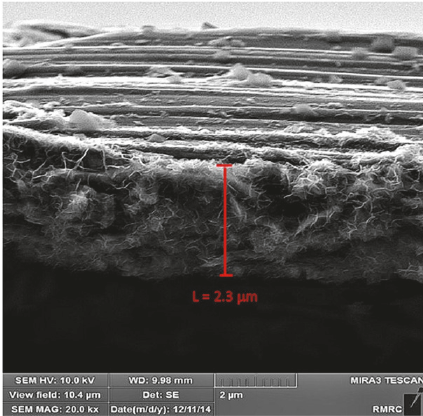
Figure 9: Cross-sectional FE-SEM image of rGO-Zn coating.